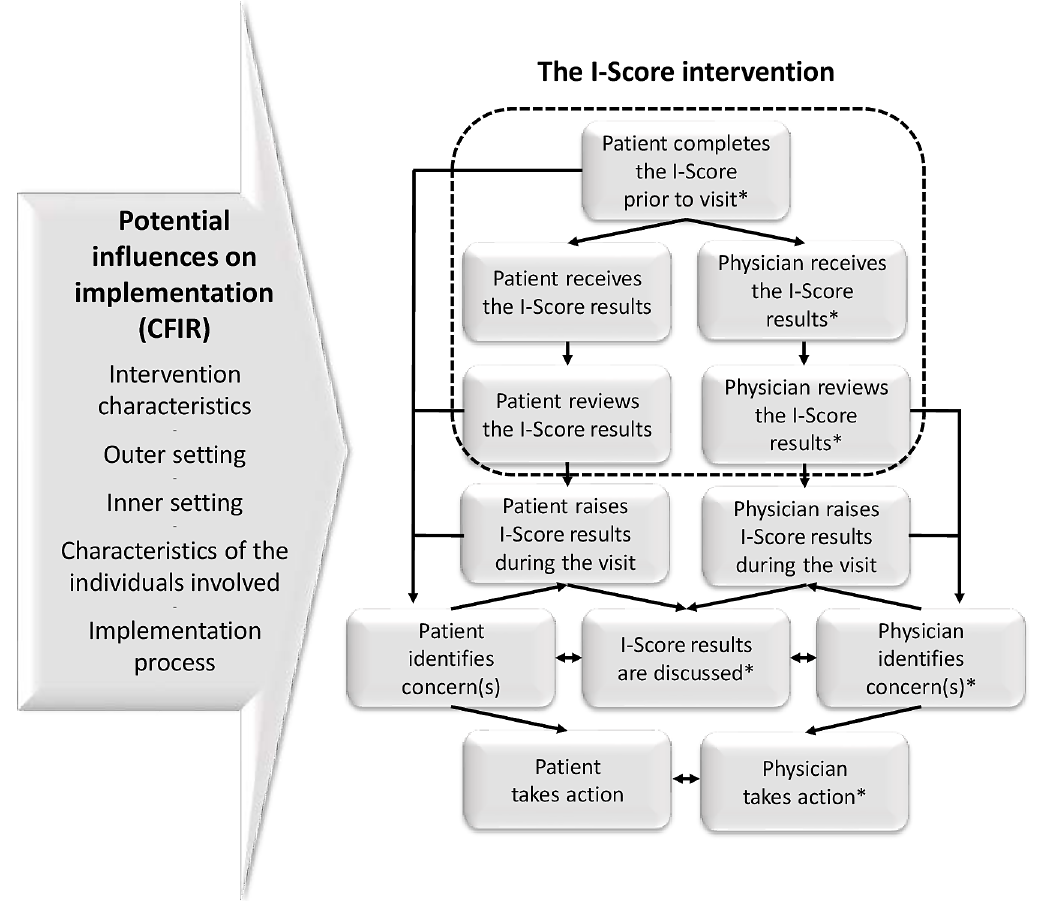
Fig 1. Guiding implementation framework and I-Score intervention logic chain. Asterisks indicate elements of the logic chain which will be examined as a part of this pilot study.